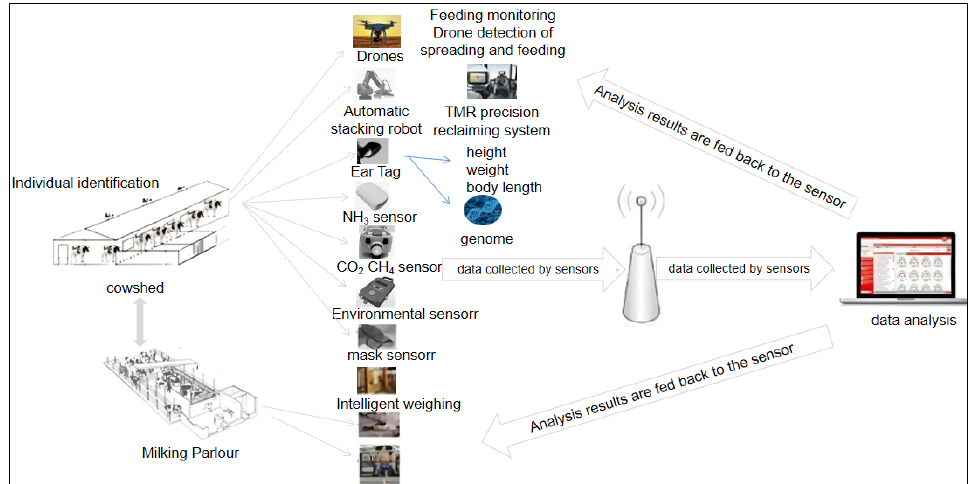
Figure 1. Structure of smart dairy farm sensing